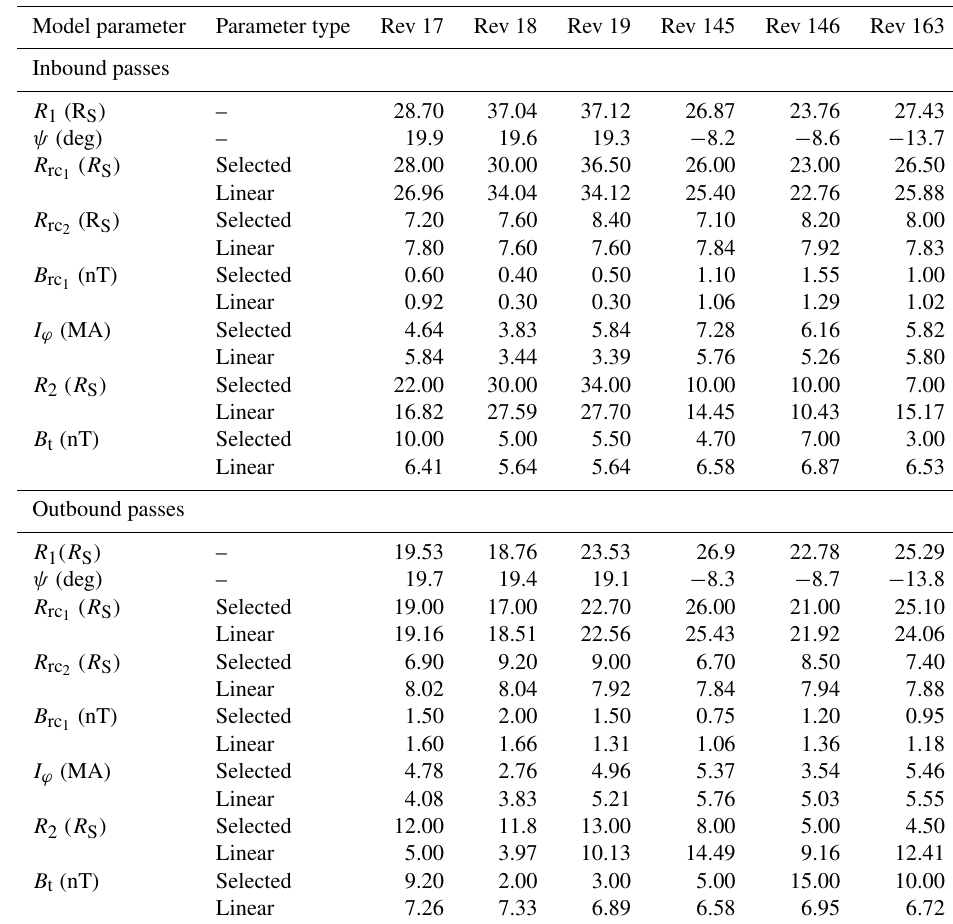
Table 3. Selected and linear model parameters for the inbound and outbound passes of Revs 17–19, 145, 146, and 163. Model parameter